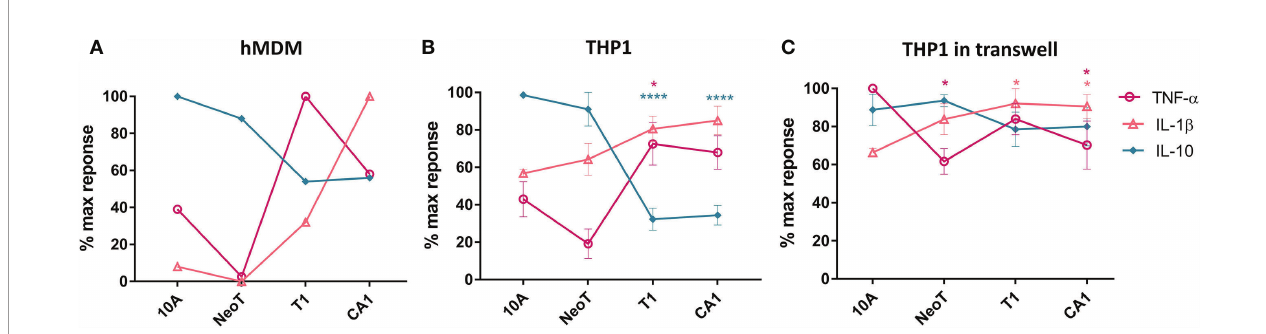
FIGURE 1 | The threshold of macrophage activation occurs between benign hyperplasia and atypical hyperplasia. (A) Cytokine production by human monocyte- derived primary macrophages (hMDM) and co-incubated with live cells from the MCF series indicated along the X-axis, at 1:5 macrophages/cell ratio. This result is representative of two experiments with two independent donors. (B) THP-1 monocyte cell line-derived macrophages were co-incubated as described in (A) . Results are presented as mean values ± SEM of three experiments. (C) THP-1 macrophages were co-incubated in a transwell plate with cells plated on top of the transwell. Cytokines were assessed in a bead-based assay and normalized against the highest cytokine concentration observed in responses to one of the cell lines. Results are presented as mean values ± SEM of three experiments. Cytokine concentrations in co-incubations with MCFNeoT (NeoT), MCFT1 (T1) and MCFCA1 (CA1) were compared to MCF10A (10A) using Fisher LSD tests for each cytokine (represented by different color): *p<0.05,